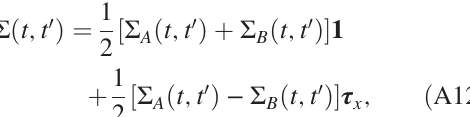
t ≥ 0 . 5 : i ; N ω ; t Þ and N ω ; t Þ i ; ↑ ð ↓ ð , max